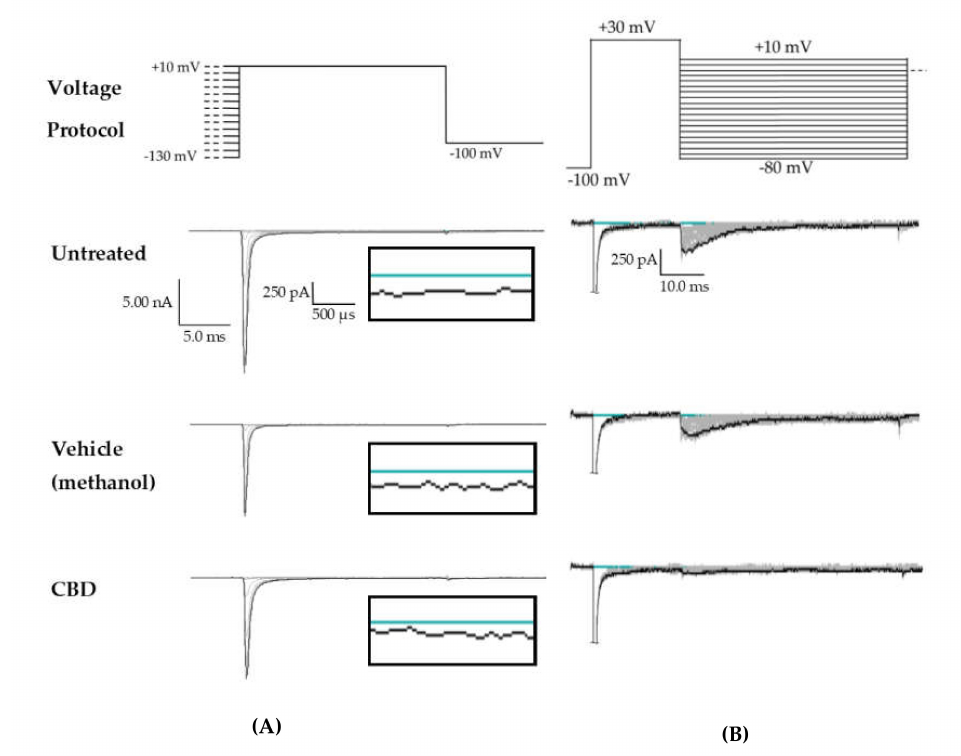
Figure 3. Raw data from cannbidiol (CBD) treatments. ( A ) Voltage protocol used to evaluate transient current (I Na T) and persistent current (I Na P) (top) and raw current trace families from representative cells, with the trace from the –130 mV prepulse step highlighted. Inset (box) shows zoom view of persistent current (I Na P). ( B ) Voltage protocol used to evaluate resurgent current (I Na R) (top) and raw current trace families from representative cells, with peak resurgent current trace